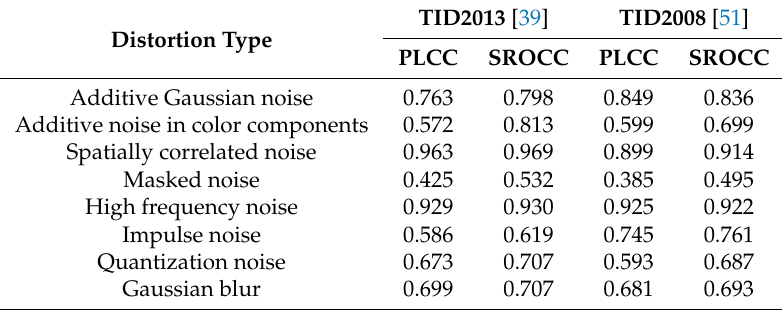
Table 4. Average PLCC and SROCC values of the proposed method for each distortion type of TID2013 [39] and TID2008